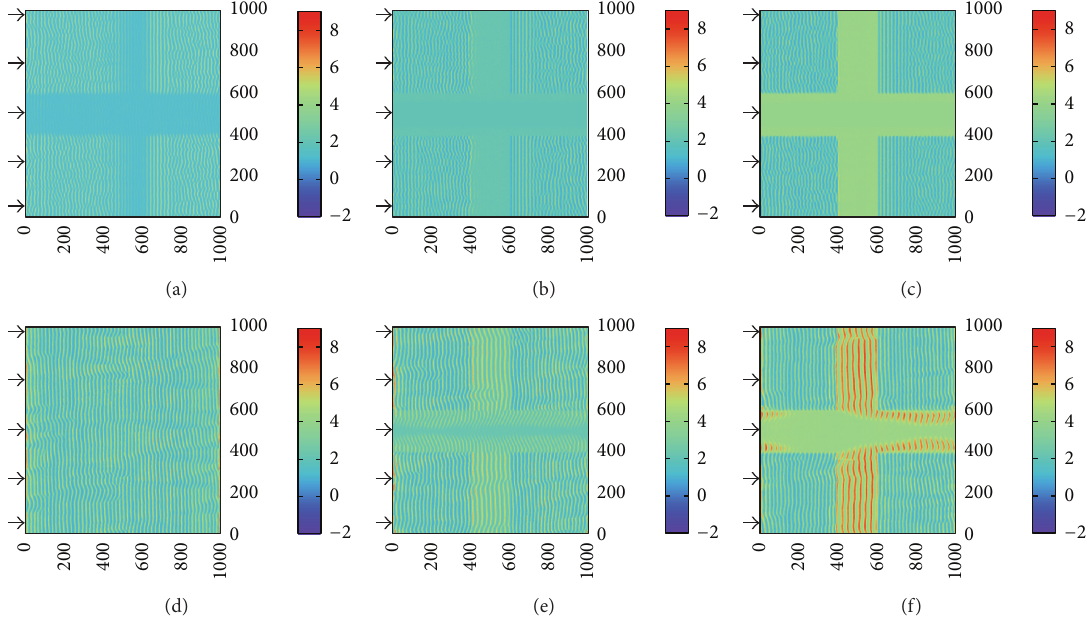
Figure 5: Simulation results of highway with crossed road; (a), (b), and (c) are the result of 100th step with height = −2 , 0, and 2, respectively; (d), (e) and (f) are the result of 2000th step with height = −2 , 0, and 2,